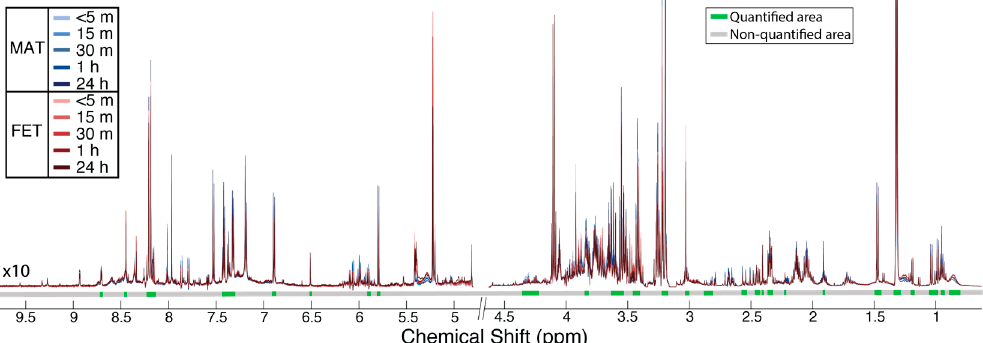
Figure 1. Overlay of mean 1 H-NMR spectra from five time points following placenta delivery: (1)